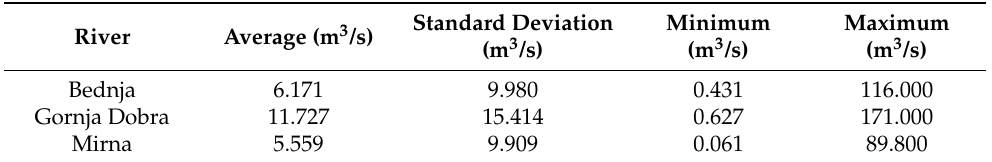
Table 2. Statistical parameters of the average daily flows for the rivers Bednja, Gornja Dobra, and